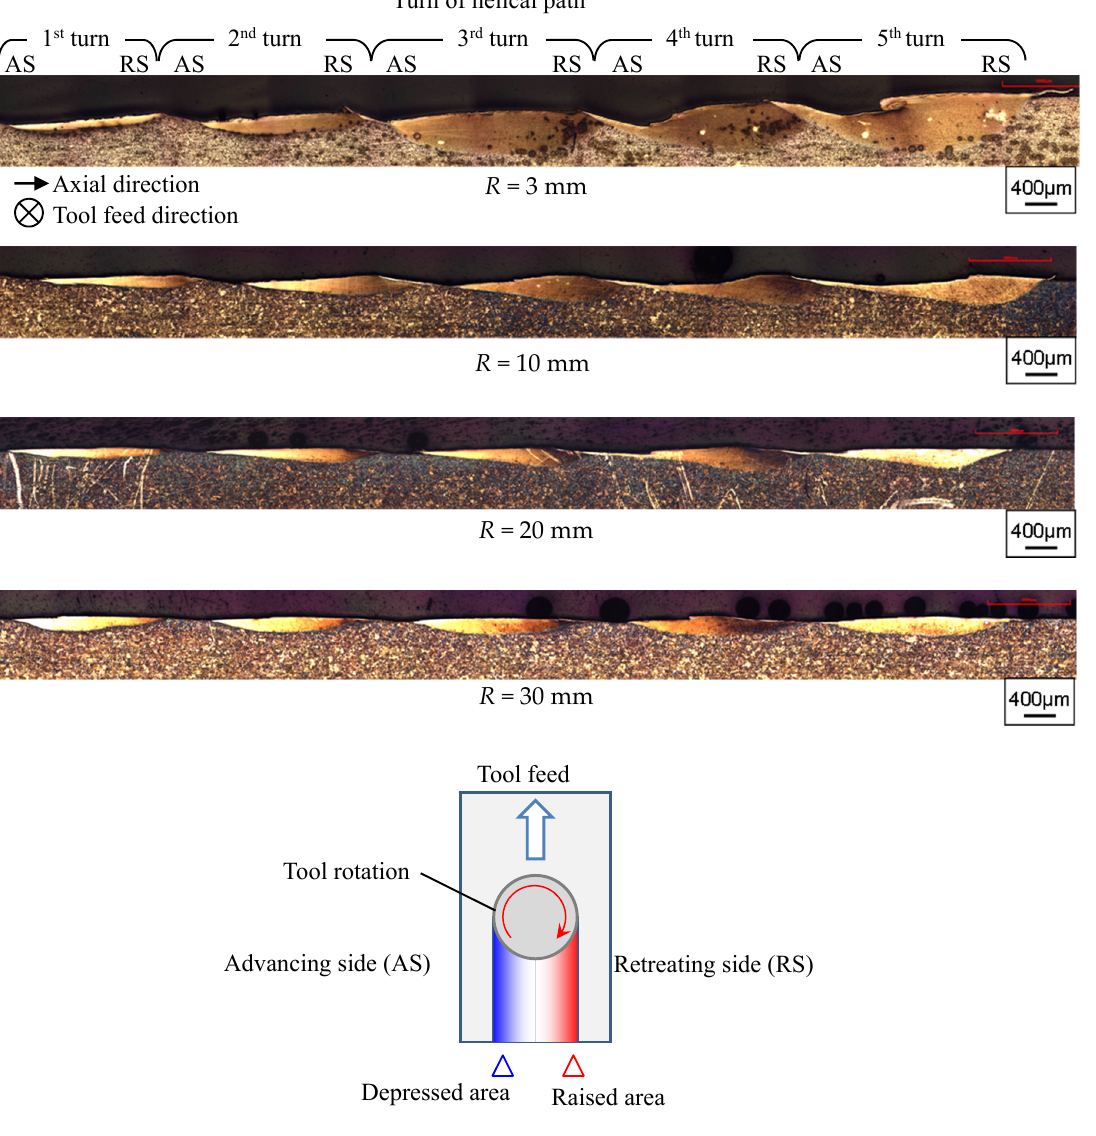
Figure 12. Cross sections of processed surfaces.